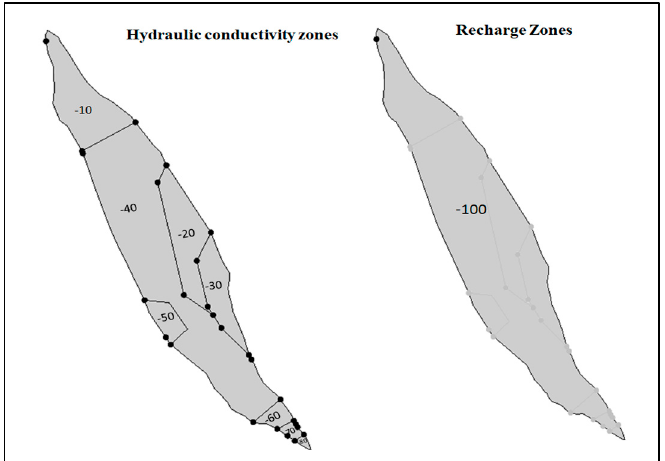
Figure 2. Recharge and hydraulic conductivity zones of Dibdibba aquifer.